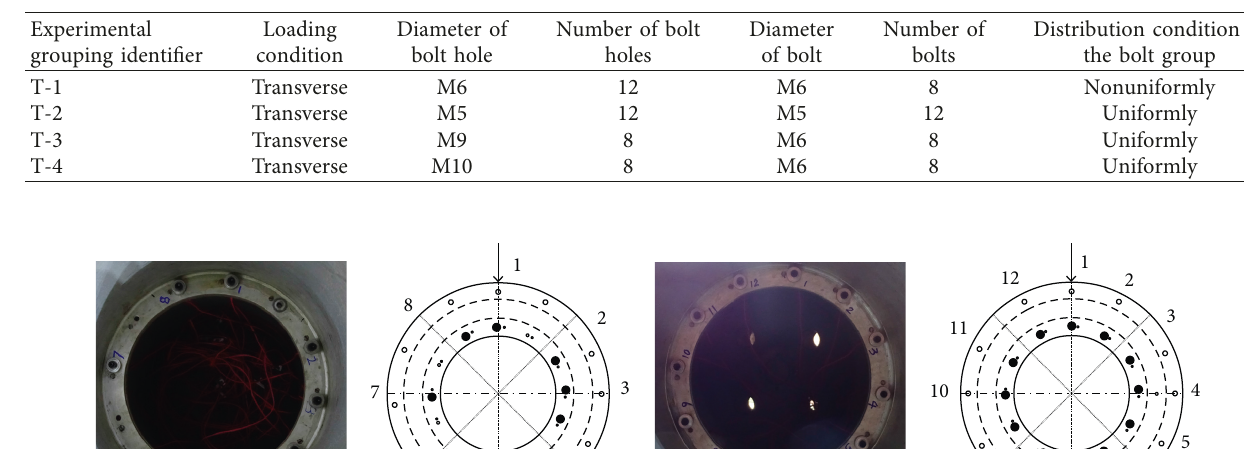
Table 1: The experimental grouping number and experimental parameters.